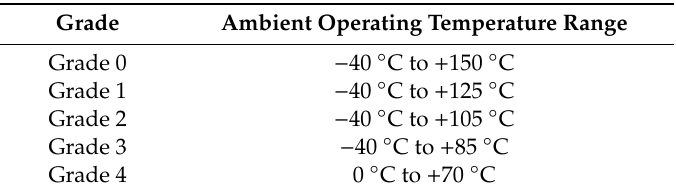
Table 1. AEC-Q100 compliant operating temperature